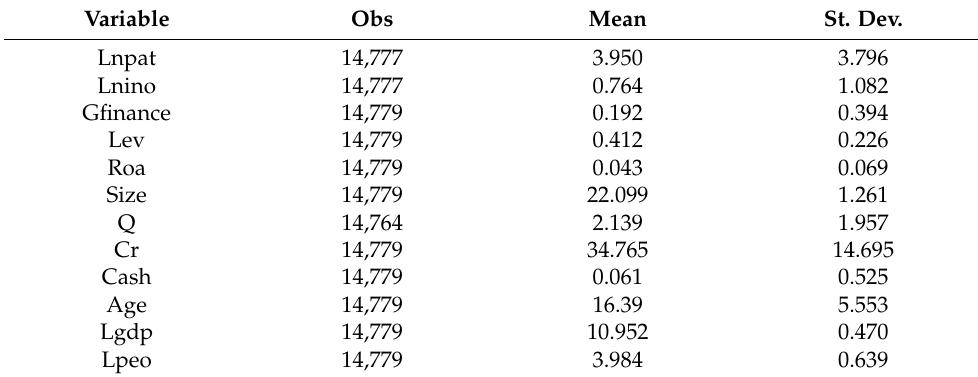
Table 2. Descriptive